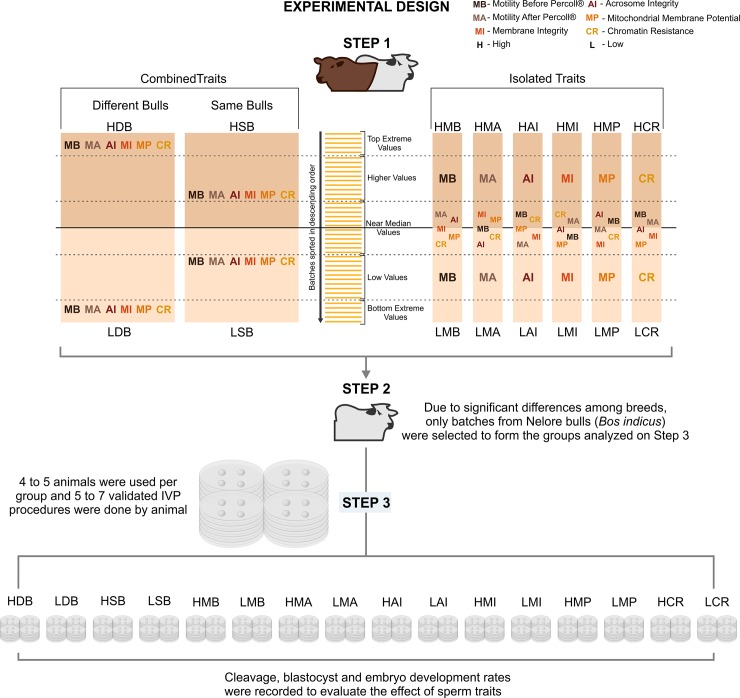
Experimental design, batches rank, representative areas used in batches selection for each step.HMB, Higher Motility Before Percoll®; LMB, Lower Motility Before Percoll®; HMA, Higher Motility After Percoll®; LMA, Lower Motility After Percoll®; HMI, Higher Membrane Integrity; LMI, Lower Membrane Integrity; HAI, Higher Acrosome Integrity; LAI, Lower Acrosome Integrity; HMP, Higher Mitochondrial Membrane Potential; LMP, Lower Mitochondrial Membrane Potential; HCR, Higher Chromatin Resistance; LCV, Lower Chromatin Resistance; HSB, Higher Sperm Traits Profile among same bulls; LSB, Lower Sperm Traits Profile among same bulls; HDB, Higher Sperm Traits Profile among different bulls; LDB, Lower Sperm Traits Profile among different bulls.